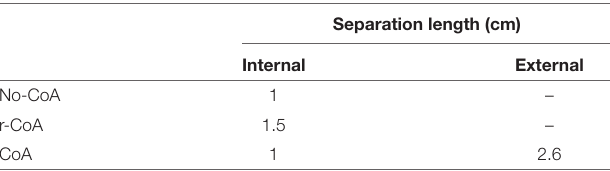
TABLE 2 | Approximate length of separations in the three aortic configurations at peak